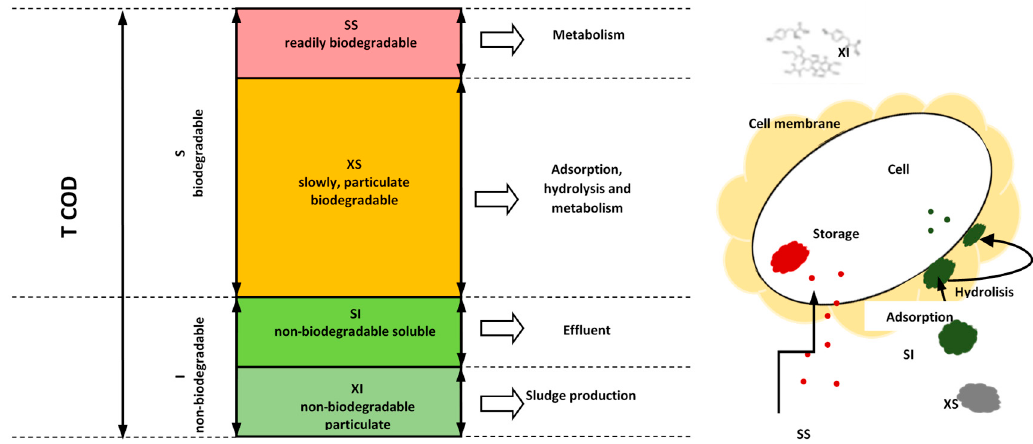
Figure 1. Schematic diagram of the chemical oxygen demand (COD) fractions and their fates in a biological wastewater treatment plant biological wastewater treatment plant [14].